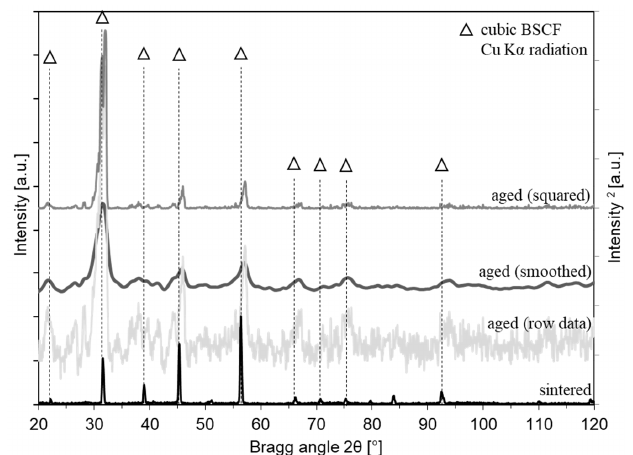
Figure A5. Cubic phase of sintered BSCF using X-ray diffraction with Cu Ka radiation and difficulties in phase analysis of the aged BSCF from the blue discolored area.